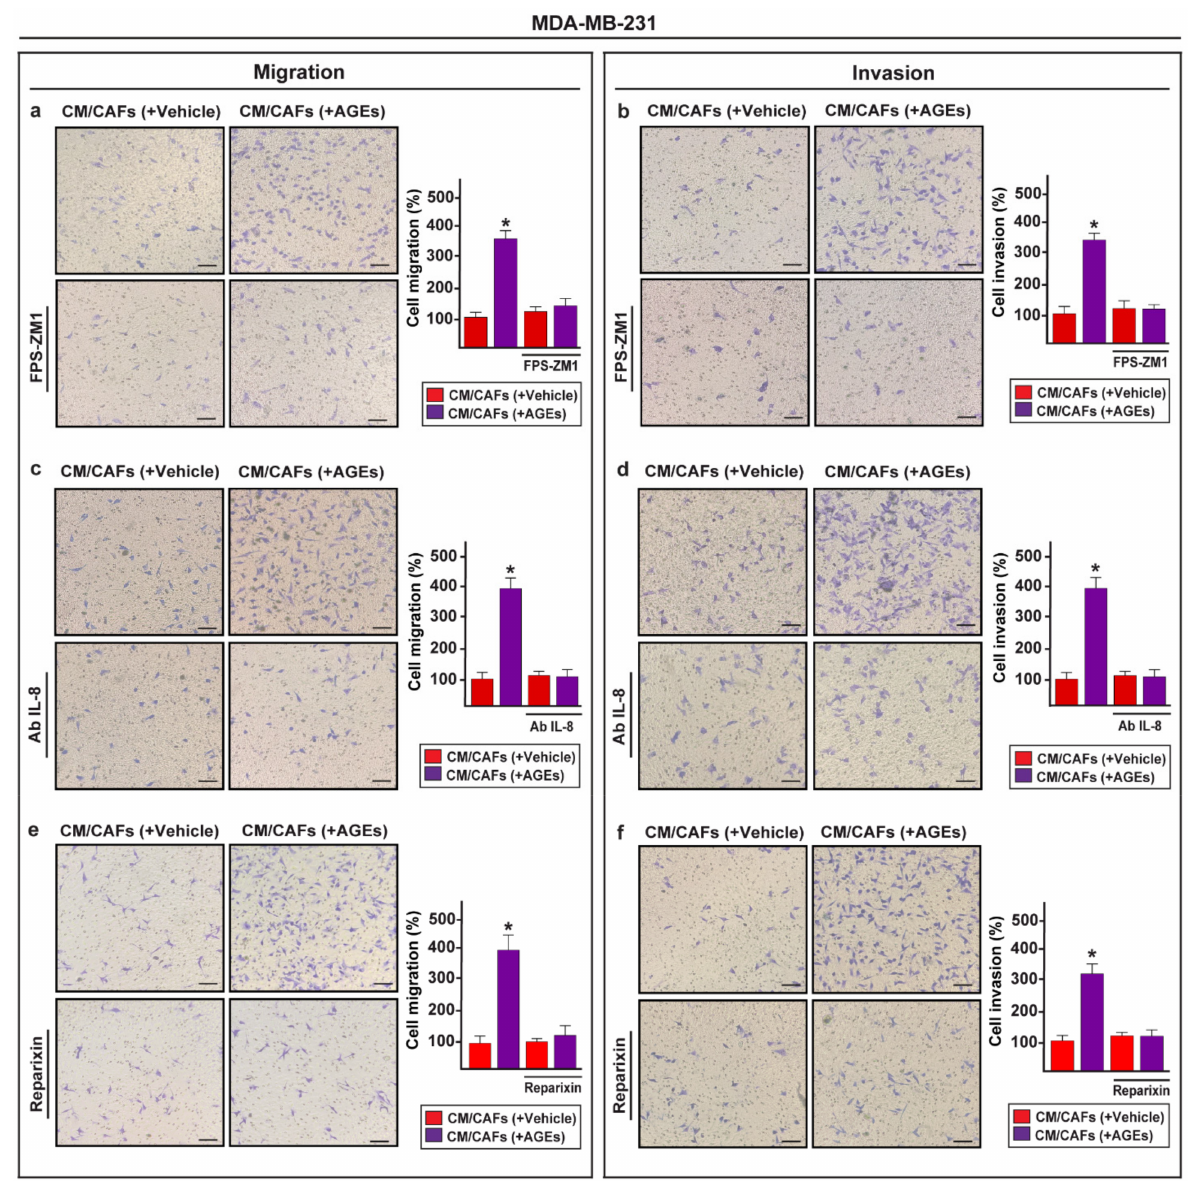
Figure 6. The paracrine activation of IL-8/CXCR1/2 axis promotes cell migration and invasion of MDA-MB-231 cells. Transwell assays were performed to evaluate cell migration ( a ) and invasion ( b ) in MDA-MB-231 cells cultured for 6 h in conditioned medium (CM) from CAFs previously treated with vehicle or 100 µ g/mL AGEs alone and in combination with 1 µ M RAGE inhibitor FPS-ZM1. Cell migration ( c ) and invasion ( d ) were assessed in MDA-MB-231 cells cultured for 6 h in conditioned medium (CM) from CAFs previously treated with vehicle or 100 µ g/mL AGEs alone and in combination with 300 ng/mL IL-8 neutralizing-antibody (Ab IL-8). The migration ( e ) and invasion ( f ) of MDA-MB-231 cells observed upon exposure to CM from CAFs previously treated with 100 µ g/mL AGEs were abolished using 5 µ M CXCR1/2 inhibitor reparixin. Scale bar = 200 µ m. Side panels show the mean ± SD of the number of cells counted in at least 10 random fields of three independent experiments performed in triplicate. (*) indicates p <